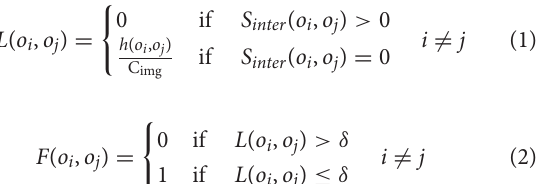
first. GCN is used to update the node features and infer